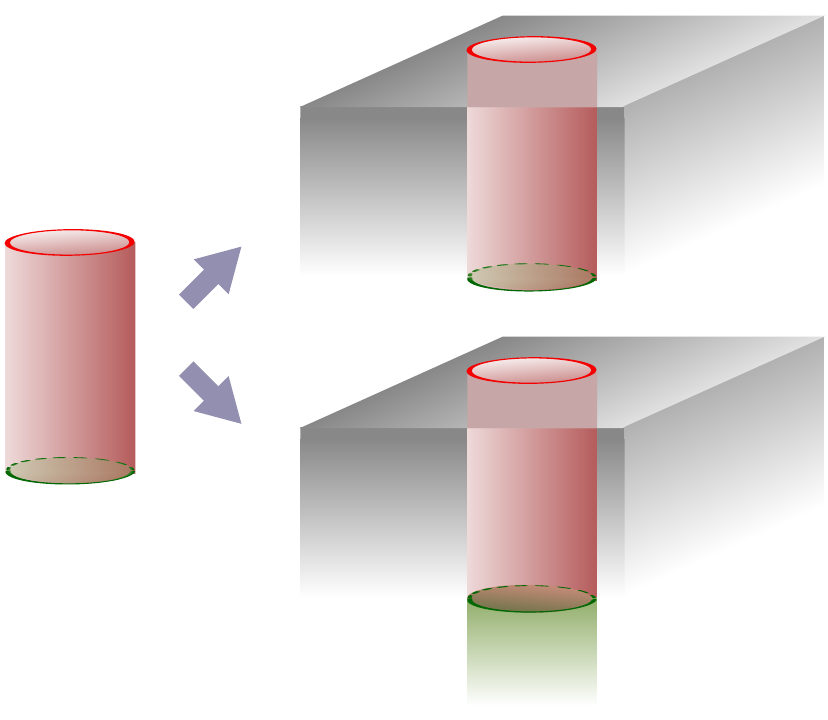
Figure 15 . Higher dimensional construction based on BCFT microstates.